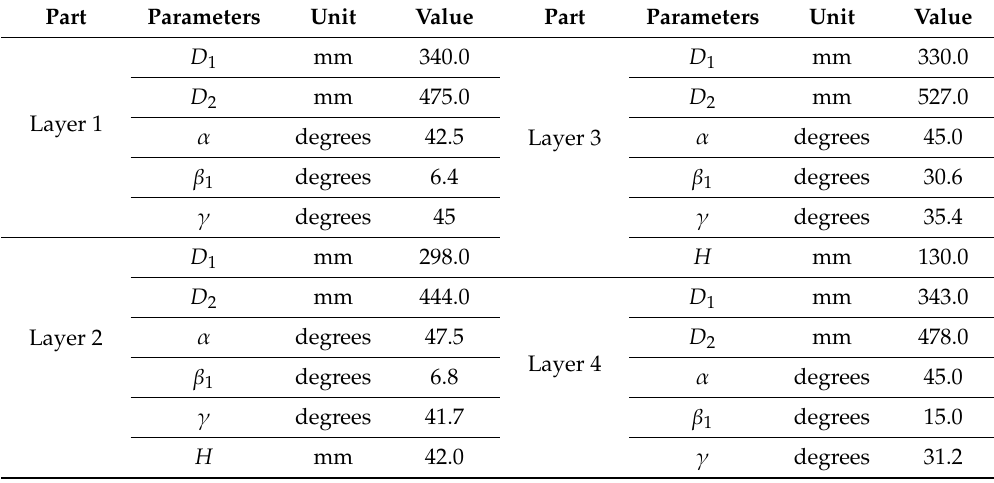
Table 3. Design values after blade optimization.